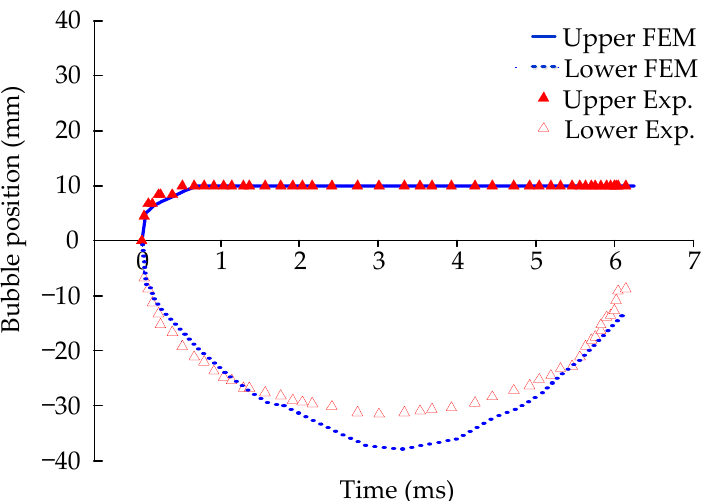
23 of 30 Figure 23. The relationship between the horizontal direction diameter of the bubble’s first pulse cycle and time when γ = 0.33 and ζ = 1.2. The blue line is the experimental measurement result. The red line is the ABAQUS/Explicit simulation result. Using Equations (25) and (26), we calculated that the maximum radius of the bubble was 33.60 mm, and the pulsation time of the first cycle of the bubble was 4.834 ms. These results are similar to those predicted using ABAQUS/Explicit. In this research, we as- sumed that the initial radius of the bubble was the same as the radius of the explosion source, and the initial bubble expansion velocity was 0 m/s. We think that these simplified settings might have affected the accuracy of ABAQUS/Explicit. Therefore, if the initial condition of the bubble is set as a practical situation, the results simulated by the finite element method will be closer to reality. The numerical model solves this problem by set- ting the gravity parameters of the entire area. GEOSTATIC* can be entered into ABAQUS